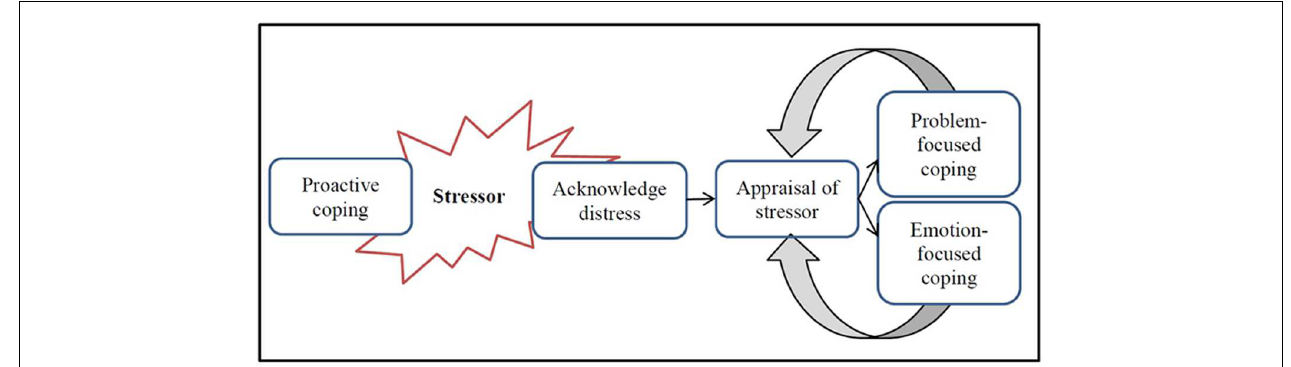
FIGURE 1 | Lazarus’ model of stress, appraisal, and